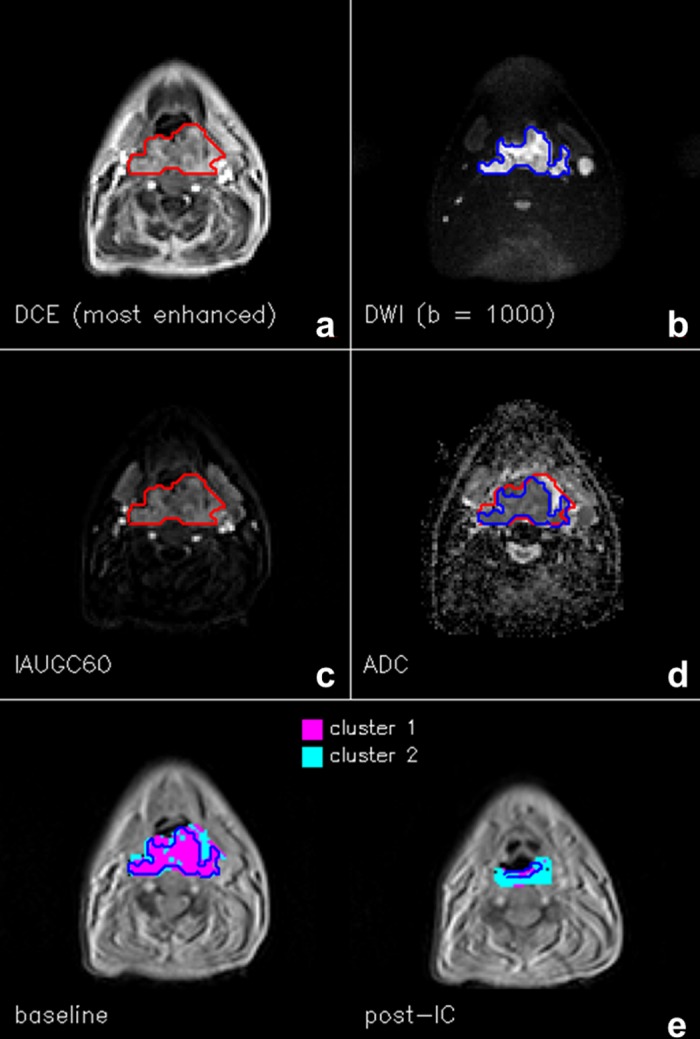
Slice with the largest tumour cross-section of a representative primary tumour.
(a) ROI (red) contoured on the most enhanced frame of the DCE series, (b) ROI (blue) contoured on b = 1000 image of the DWI series, (c) IAUG60 map, (d) ADC map, with the two ROIs overlapped, and (e) cluster analysis map pre and post-induction chemotherapy (IC), in the simplest case of k = 2. The red ROI also encompasses the region where cluster analysis was performed; the blue ROIs represent the area of restricted diffusion independently contoured on DWI data, almost coincident with Cluster 1, which is characterized by both low ADC and high IAUGC60 values.